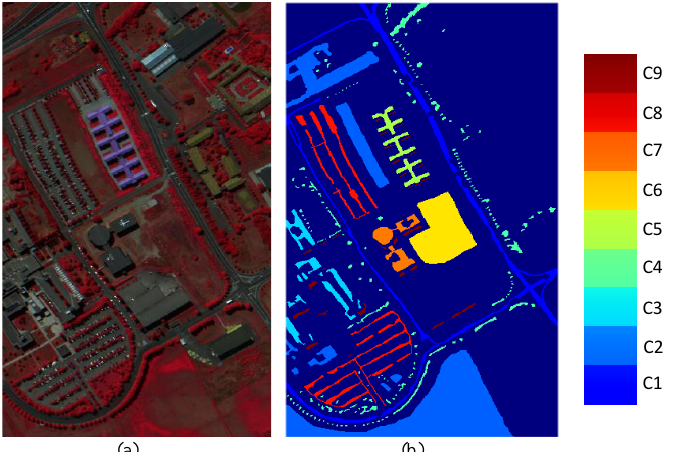
Figure 6. Pavia University scene dataset. ( a ) false-color composite of the Pavia University scene; ( b ) ground truth map containing nine mutually exclusive land cover classes.